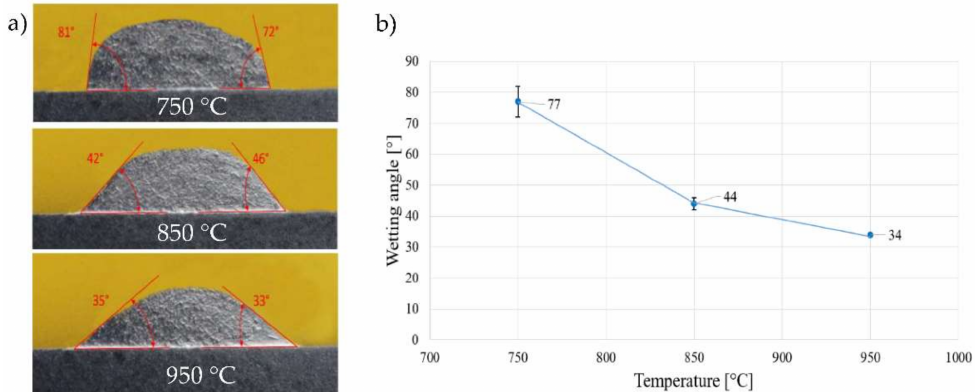
Figure 7. Thermal cycle of soldering with following thermal phases: 1—heating phase, the rate of 90 ◦ C/min; 2—holding phase, the average temperature of 853 ◦ C during 5 min; 3—cooling phase, the rate of 15.6 ◦ C/min.